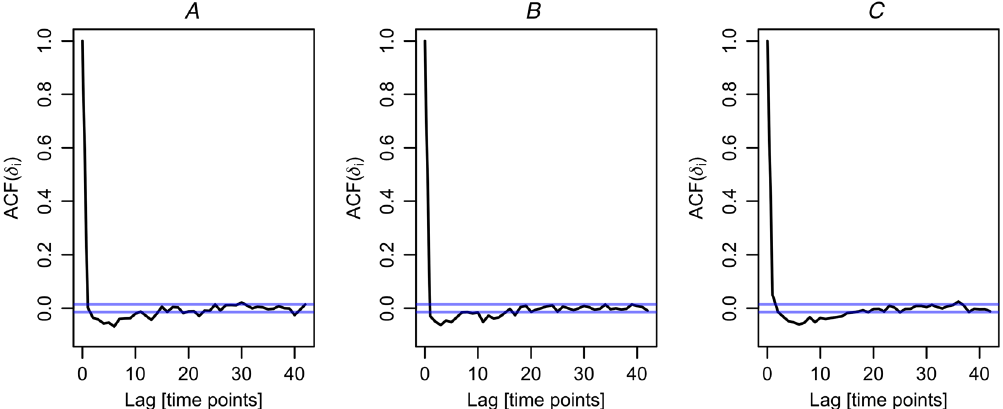
FIG. 9. Autocorrelation of count-smoothing residuals. The autocorrelation function of the residual from the count-smoothing − w procedure, δ log a , was calculated for one of the replicates and each species, with lag measured in time points (400 s). The blue i ¼ i i line shows the 95% confidence interval. The rapid decay observed here was typical for all